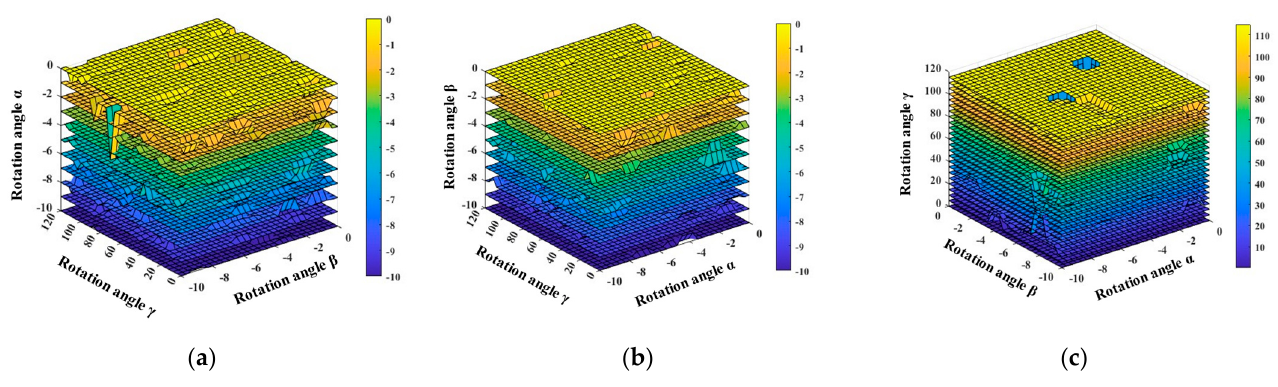
Figure 5. ( a ) The measured value of rotation angle α ; ( b ) the measured value of rotation angle β ; ( c ) the measured value of rotation angle γ . ( c ) the measured value of rotation angle γ